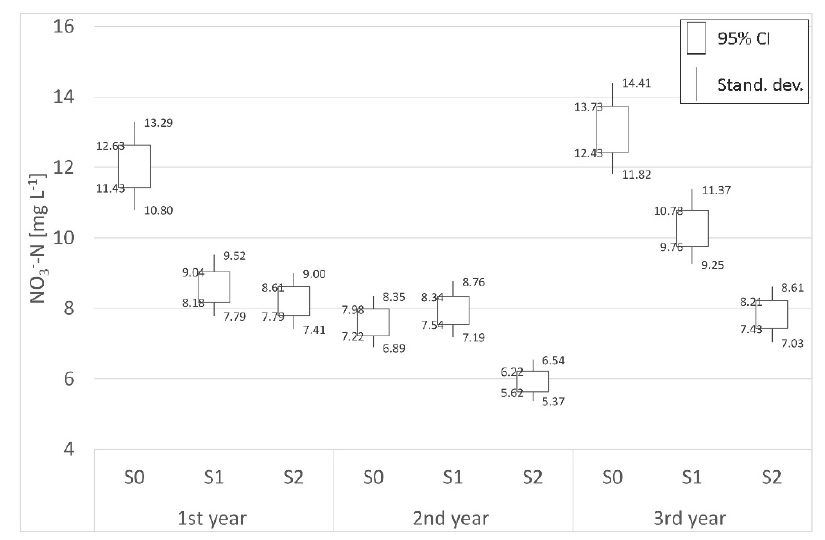
− -N in groundwater under shelterbelt soils. 3